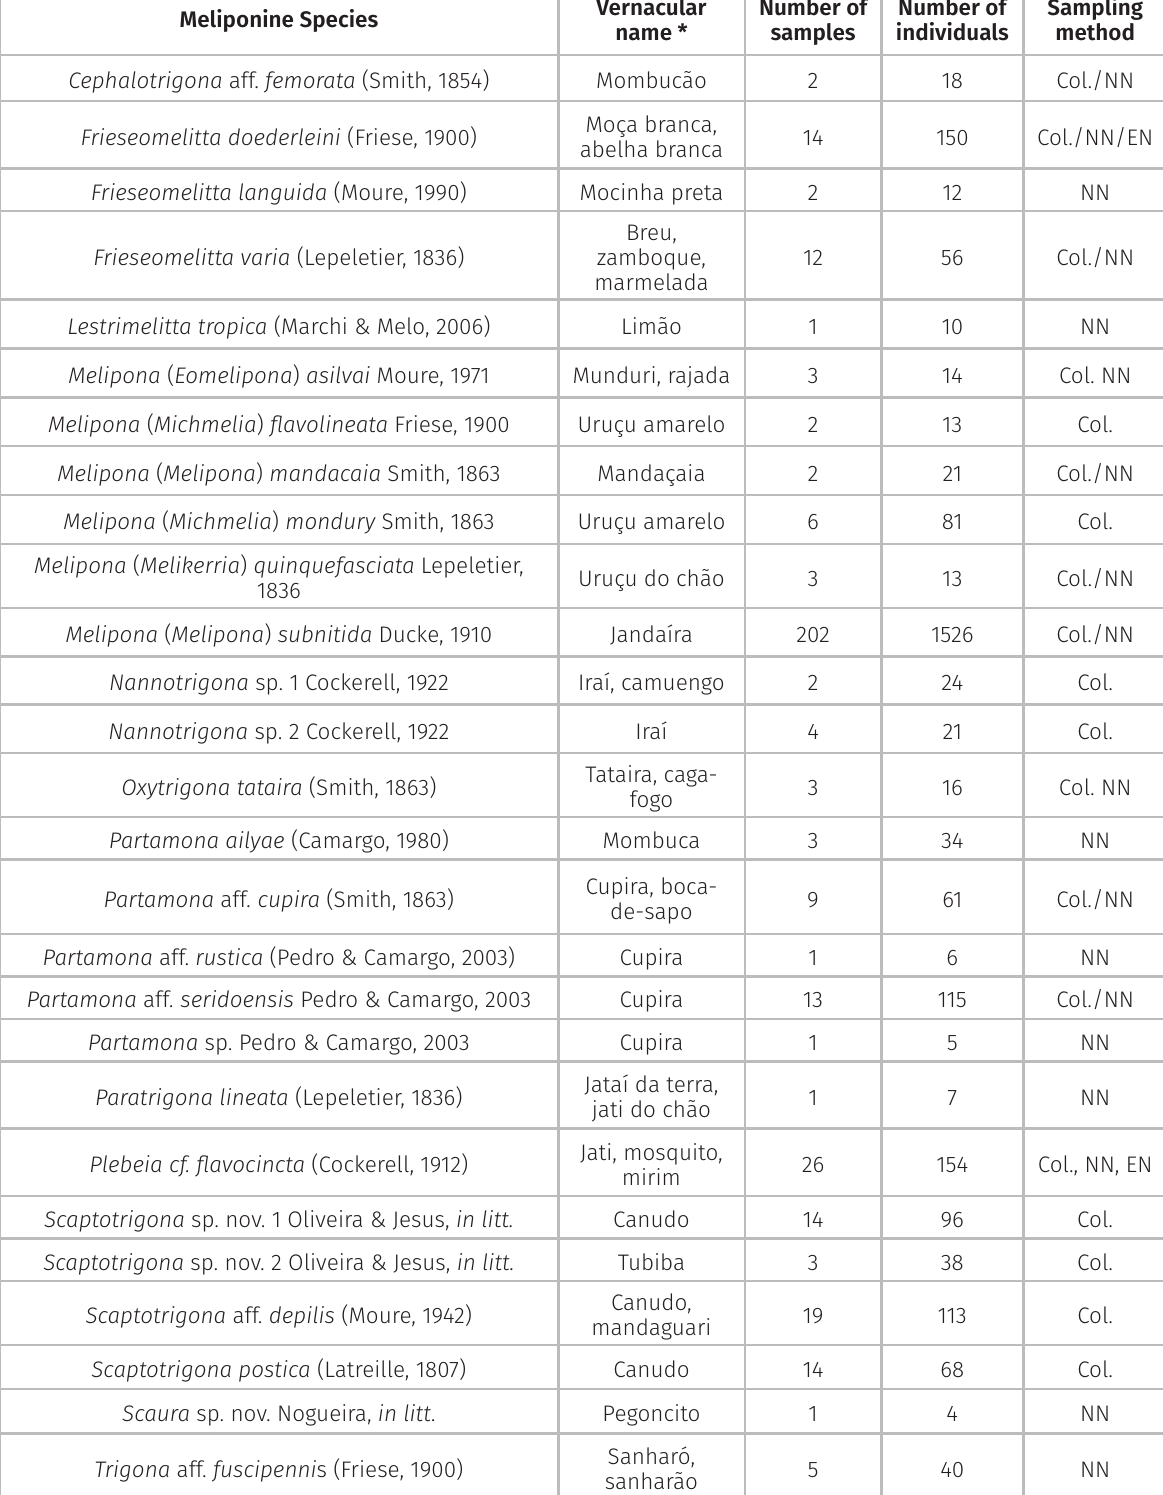
Table I. Richness of meliponine species found in the State of Ceará, Brazil, in 2013 and 2014. Meliponine